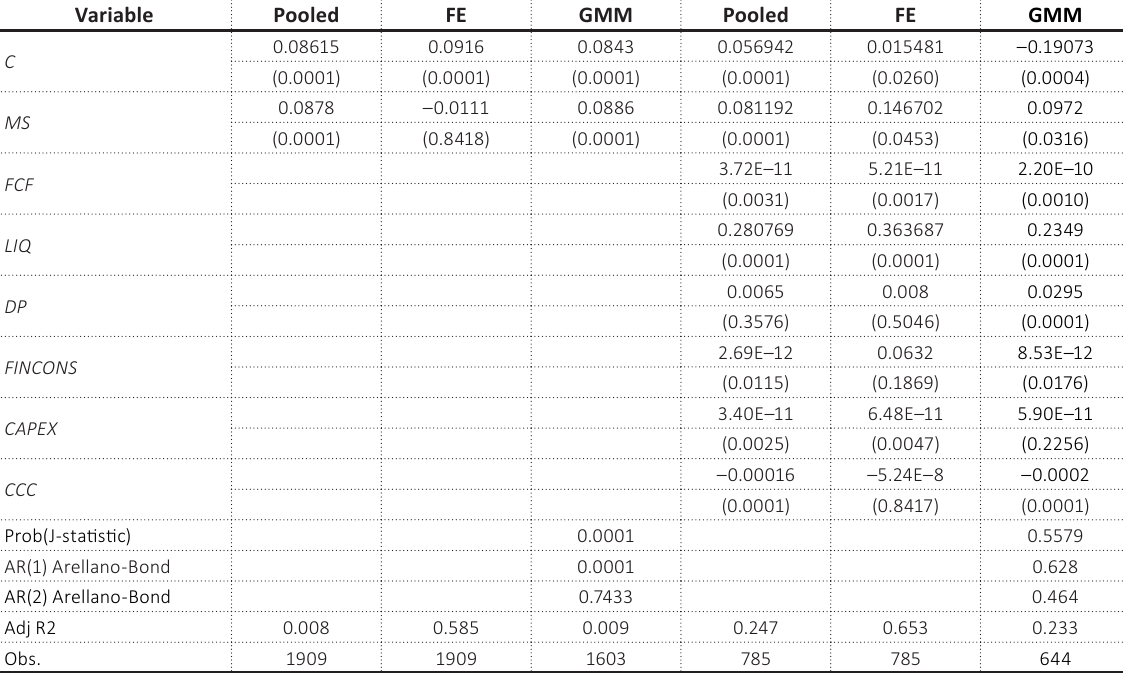
Table 3. Empirical determinants of cash level for GCC